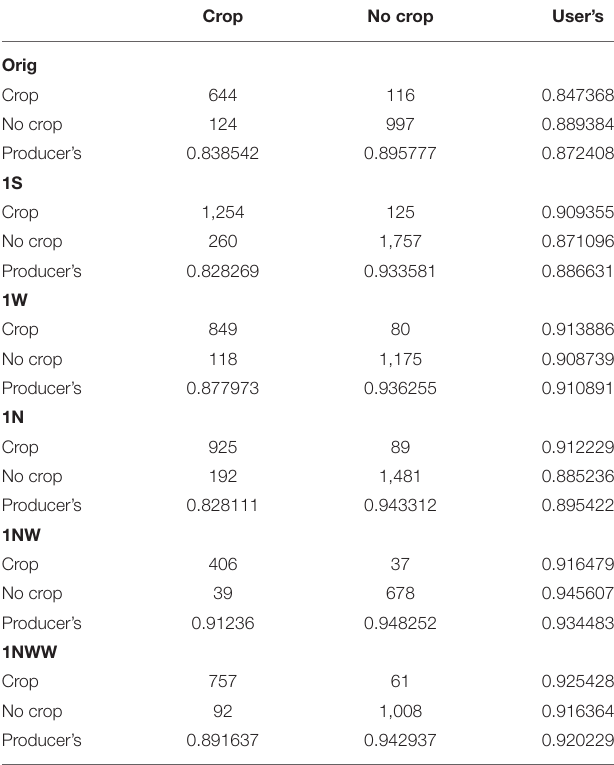
TABLE 4 | Confusion matrices for the primary six tiles, with the classes aggregated to crop/no